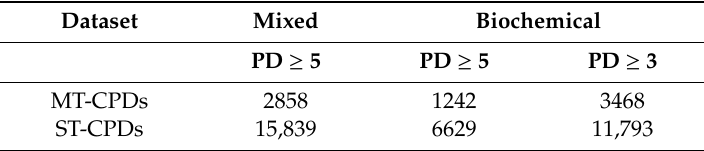
Table 3. Composition of datasets for machine